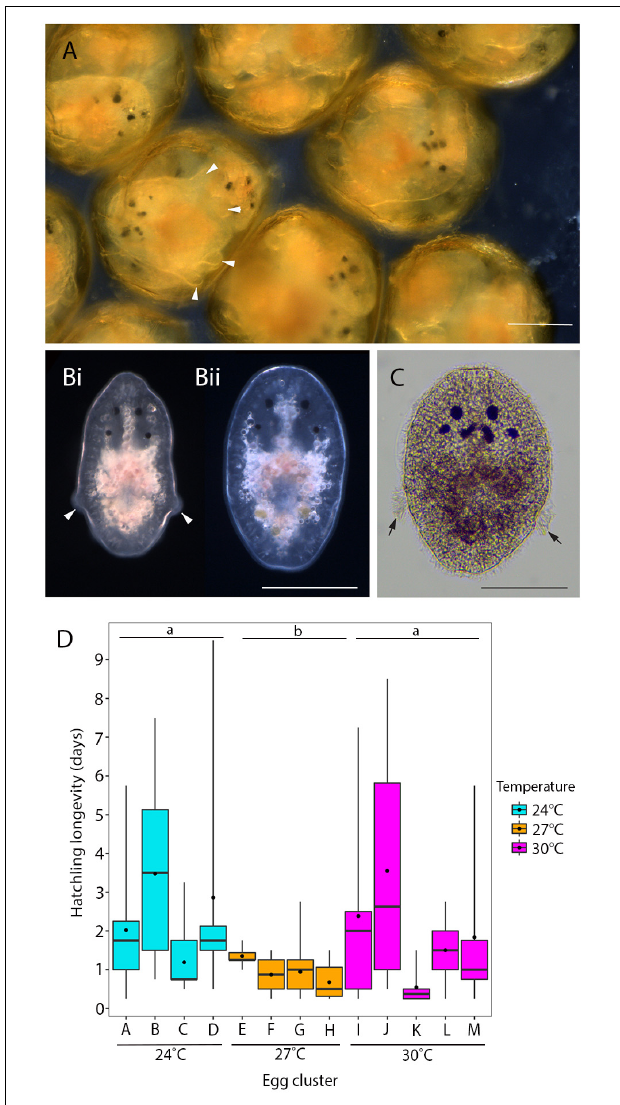
FIGURE 3 | Hatchling morphology and longevity of P. acroporae . (A) Live embryos developing inside the egg capsule showing pronounced larval lobes (arrowheads). (B) At hatching these lobes are either much reduced (arrowheads) (Bi) or lost entirely (Bii) (live hatchlings). (C) Hatchlings that have lost their lobes retain the ciliary tufts (arrow; fixed specimen). Scale = 100 µ m. (D) Hatchling longevity (the number of days a hatchling survives in the absence of coral) at 24 ◦ C ( n = 64, 4 egg clusters), 27 ◦ C ( n = 81 individuals, 4 egg clusters), and 30 ◦ C ( n = 62, 5 egg clusters) (error bars = min. and max. values, boxes = lower and upper quartiles, line = median, and dot = mean). Overall temperature did not influence hatchling longevity ( p > 0.05), but pairwise comparisons show significant differences between 24 and 27 ◦ C ( p < 0.001) and 27 and 30 ◦ C ( p < 0.001). Treatments with the same letter are not significantly different from each other ( p > 0.05).